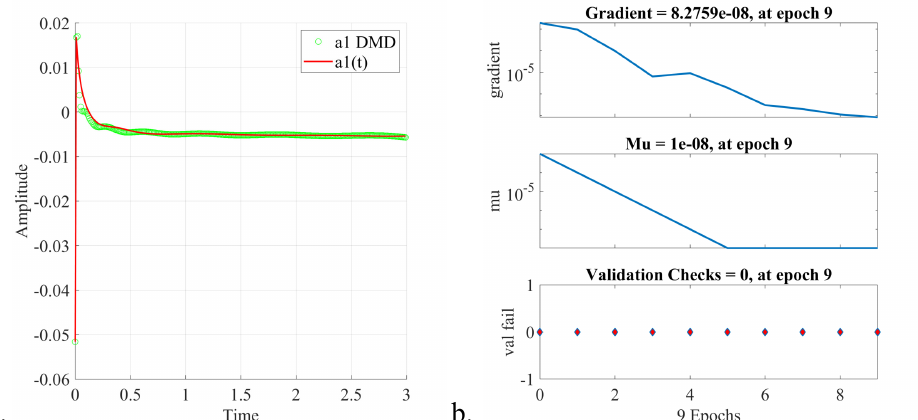
Figure 13. ( a , b ) The CPU time required in the offline-online stage, for the three test cases. Figures 14–16 illustrate the validation for the first temporal coefficient, as simulated response of the optimal NLARX estimator, in the case of the three experiments, respectively. The dots represent the discrete data for the training of the neural network, while the line represents the continuous model of the temporal coefficient determined by the NLARX model network.